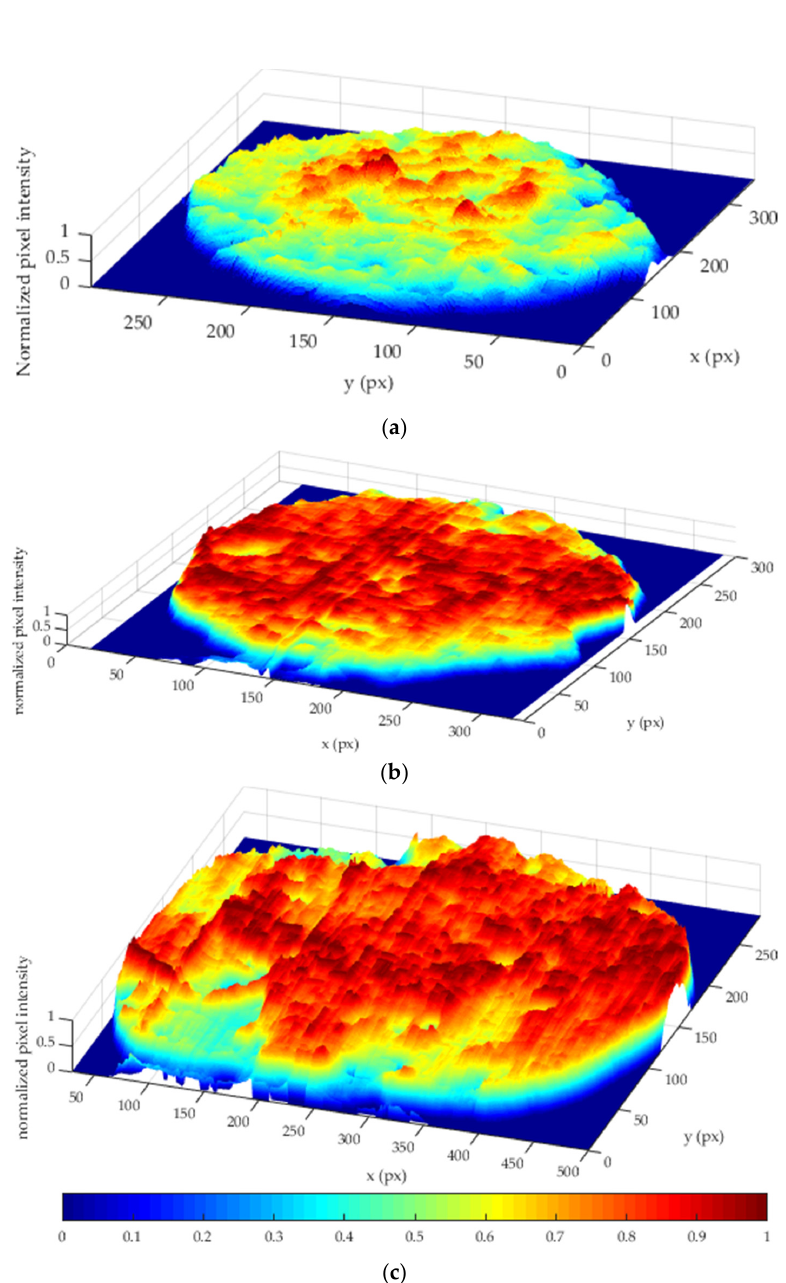
Figure 9. 3D fouling volume representation. ( a ) Gravy, ( b ) tomato, and ( c ) malt.